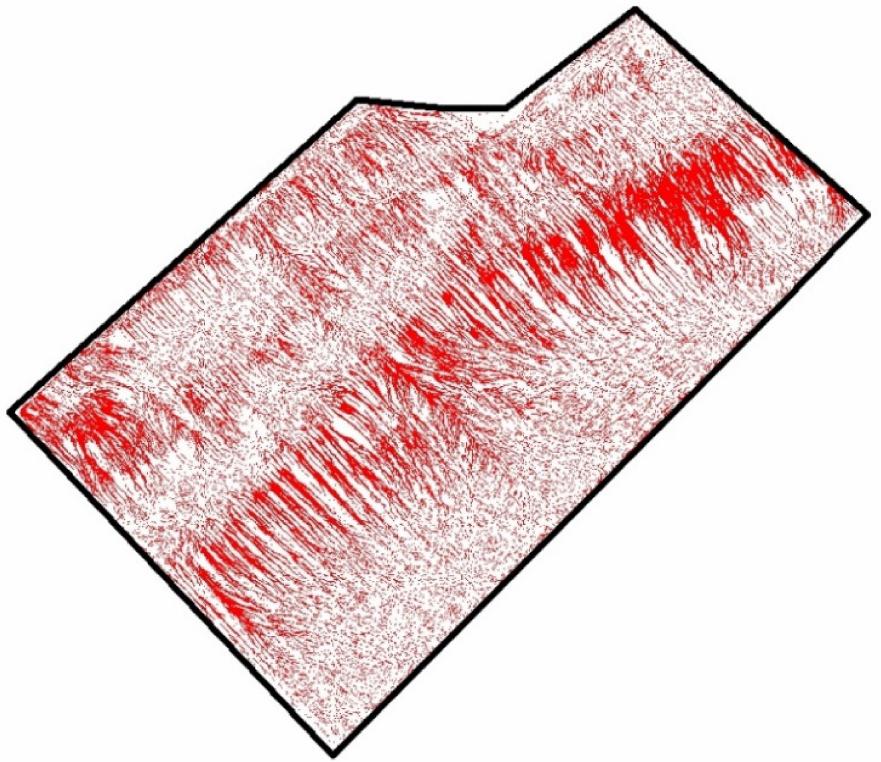
Figure 6. Distributed CN-VSA method—step 4: identification of spatial location of saturated areas in a watershed using TWI map and threshold λ